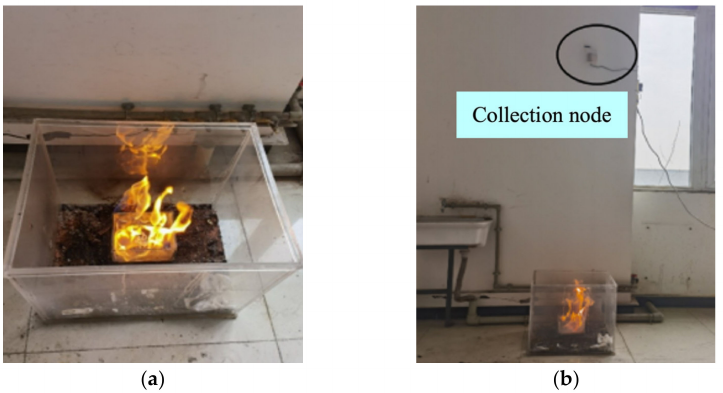
Figure 14. The alcohol fire test: ( a ) the process of alcohol combustion; ( b ) the fire scene.